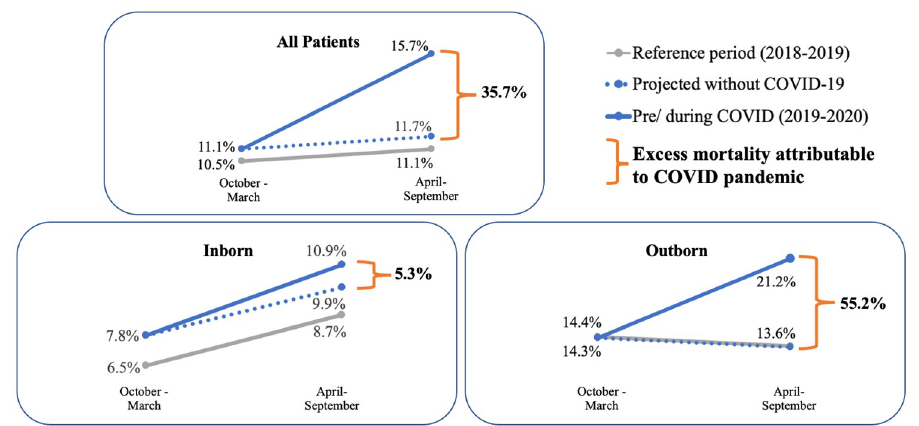
Fig 2. Newborn mortality by birth location including expected mortality trend (dotted lines) without the COVID- 19 pandemic based on seasonally matched periods prior to COVID-19. Excess mortality is the amount of mortality seen above what would be expected for trend, calculated as the relative difference between periods divided by mortality in the reference period. 1,234 patients were outborn (born outside Kiwoko hospital) and 1,260 born at Kiwoko (inborn) during the periods of study.